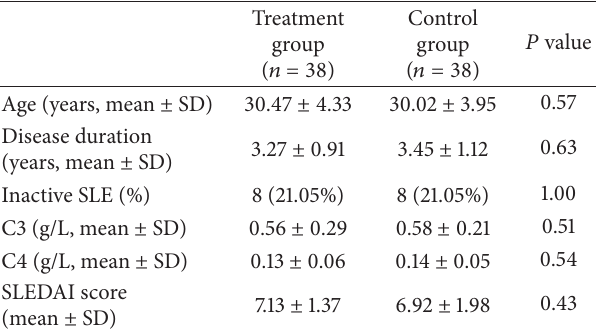
Table 1: Baseline demographic features, clinical findings, and SLEDAI scores in the pregnant SLE patients.